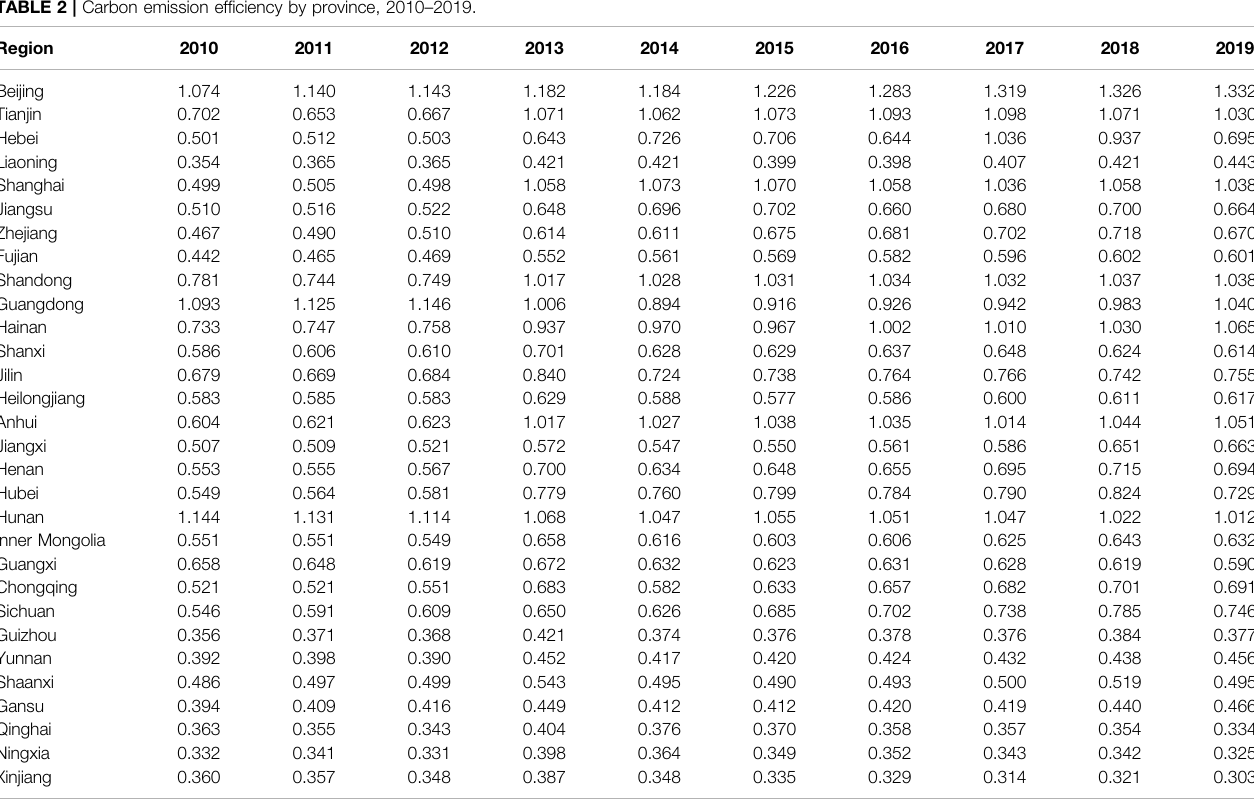
TABLE 2 | Carbon emission ef fi ciency by province, 2010 – 2019.